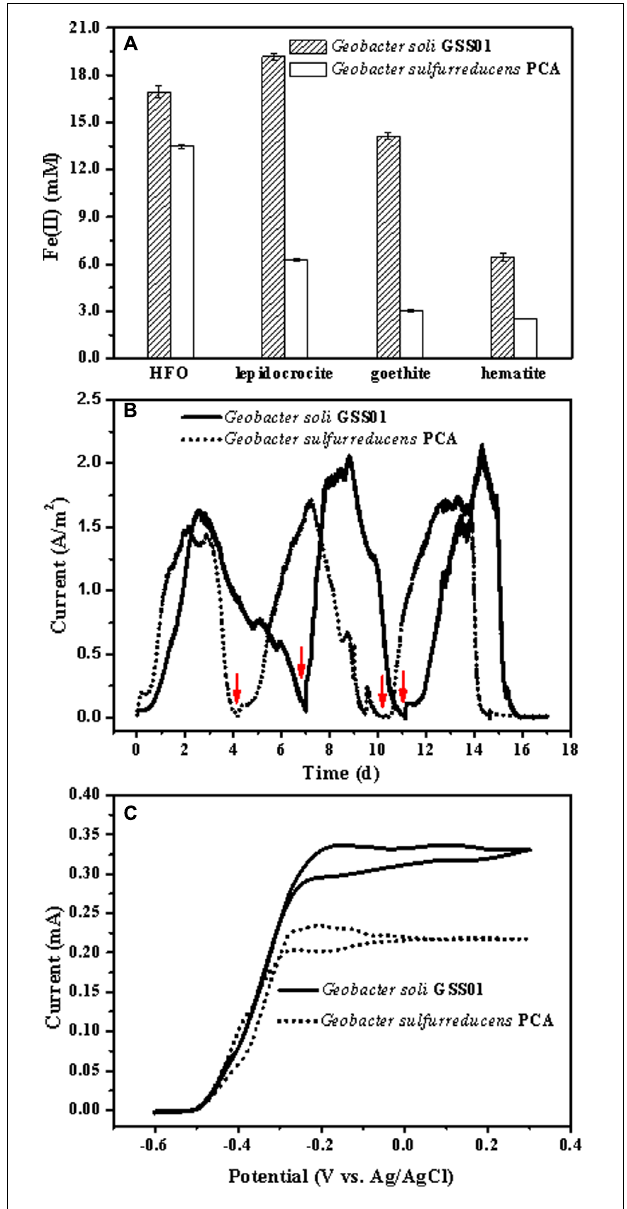
FIGURE 1 | Comparison of the EET capability of G. soli GSS01 and G. sulfurreducens PCA. (A) Fe(III) oxide reduction following a 15-day reaction. (B) Electrical current generation. Arrows indicate the medium change. (C) CVs of electroactive bioanodes under turnover conditions (scan rate: 1 mV/s). Vertical bars indicate mean ± SD (standard deviation) of three replications. Results for electrical current generation and CVs are representative of triplicate